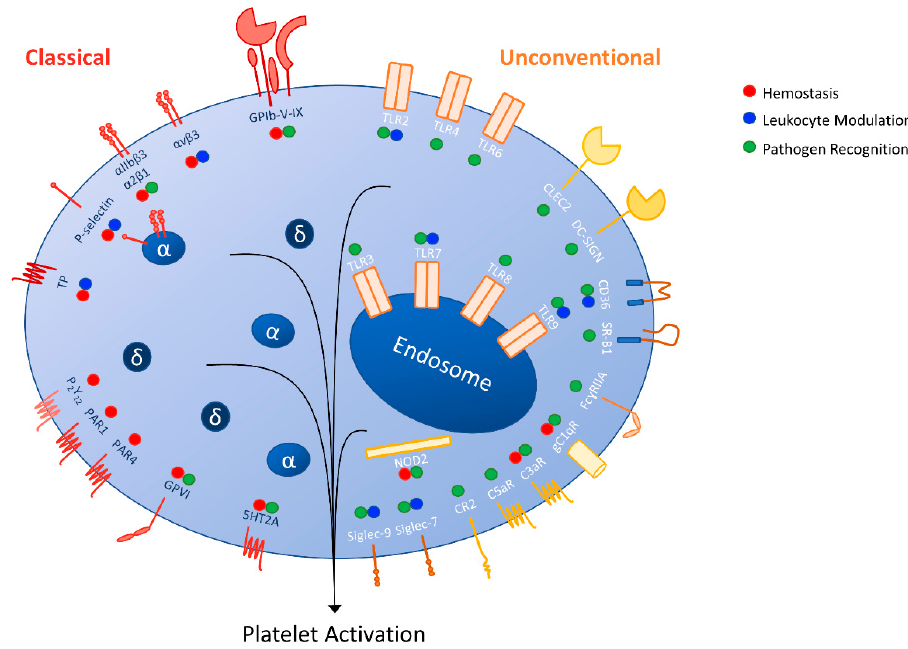
Figure 1. Classical and unconventional platelet receptors and their contributions to immunity and hemostasis.